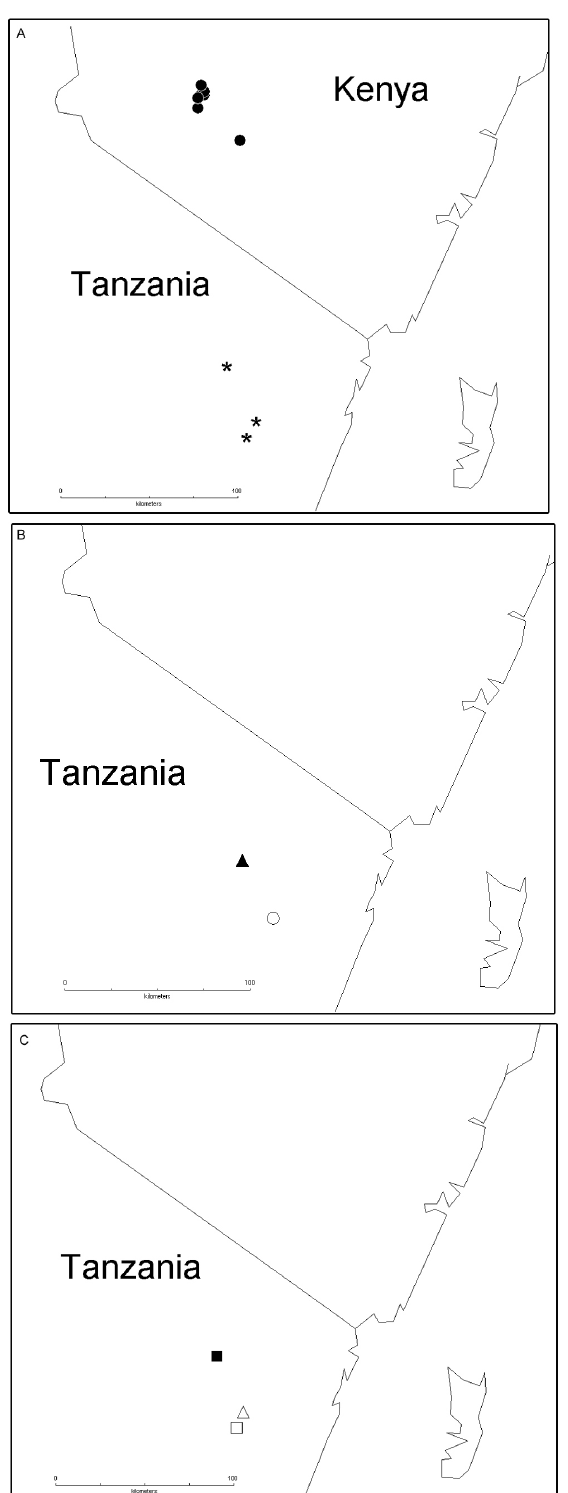
Fig. 14. Distribution maps. A. Cteniogaster hexomma sp. nov. (●), C. toxarchus gen. et sp. nov. (*). B. Cteniogaster lampropus sp. nov. (▲), C. nana sp. nov. (○). C. Cteniogaster taxorchis sp. nov. (□), C. conviva sp. nov. (■), C. sangarawe sp. nov.